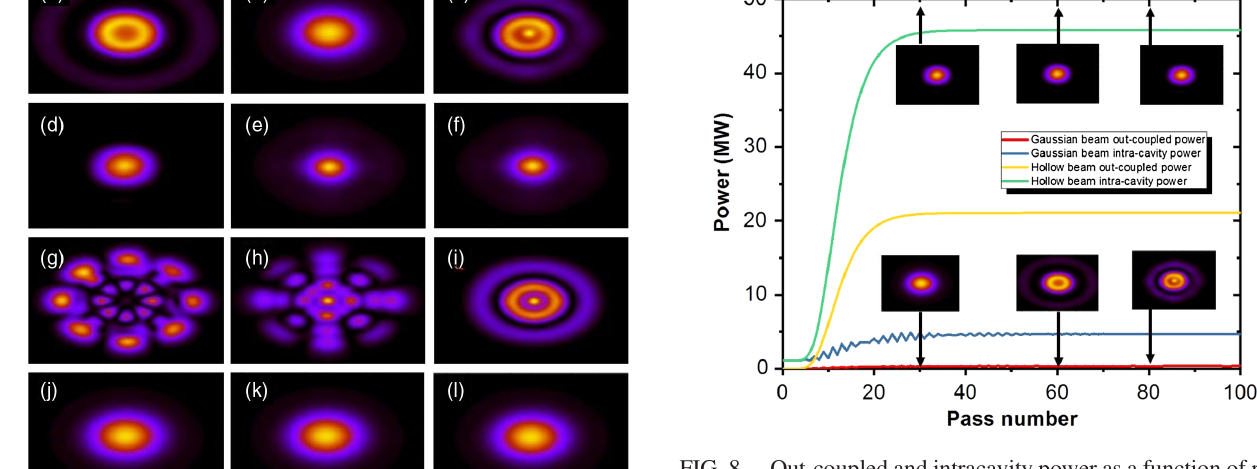
FIG. 8. Out-coupled and intracavity power as a function of pass number for the Gaussian and hollow beams. Also shown are the transverse modes at the out-coupling mirror after the 30th, 60th and 80th passes, for both beams. With g ¼ − 0 . 6 and λ ¼ 10 μ